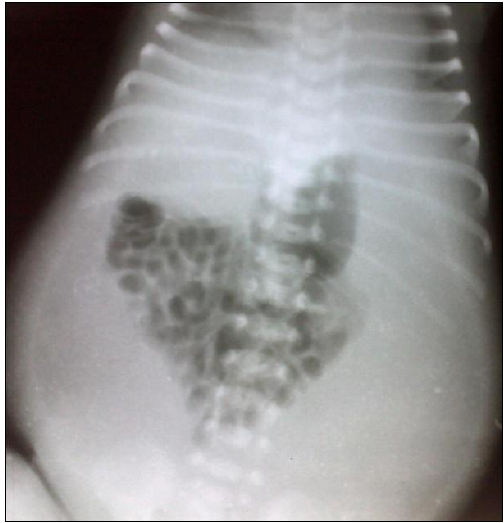
Figure 1: Abdominal